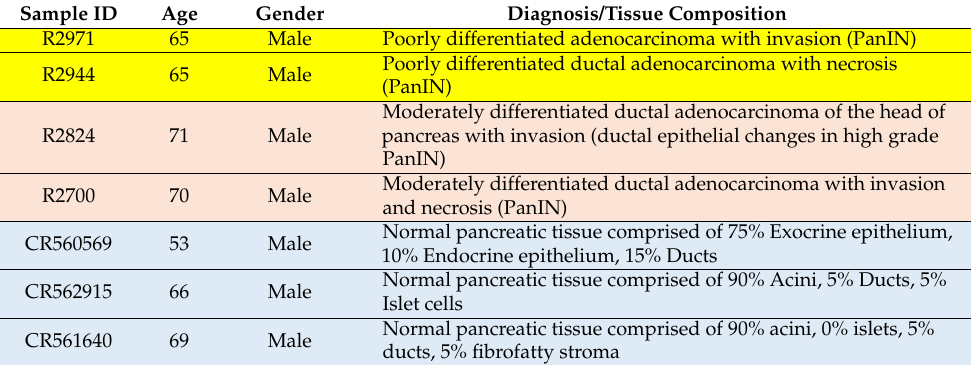
Table 2. Data on patient samples of RNA taken from human PDAC tumors and the normal pancreas samples used in this